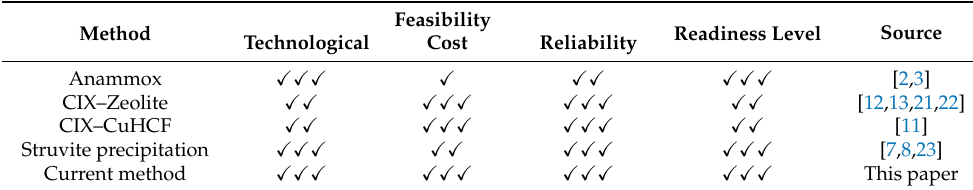
Table 1. Comparison of varied methods for ammonia removal and reuse from WWTP dewatering supernatant (three (cid:88) =